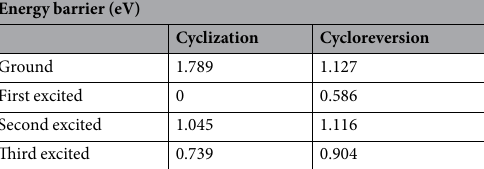
Using equations 4–11 with the obtained photo-switching properties, we derived the component terms (Table S3) of density matrix equations relevant to spontaneous decay and vibrational relaxation. f boltzmann indicates the Boltzmann factor in equation 7.